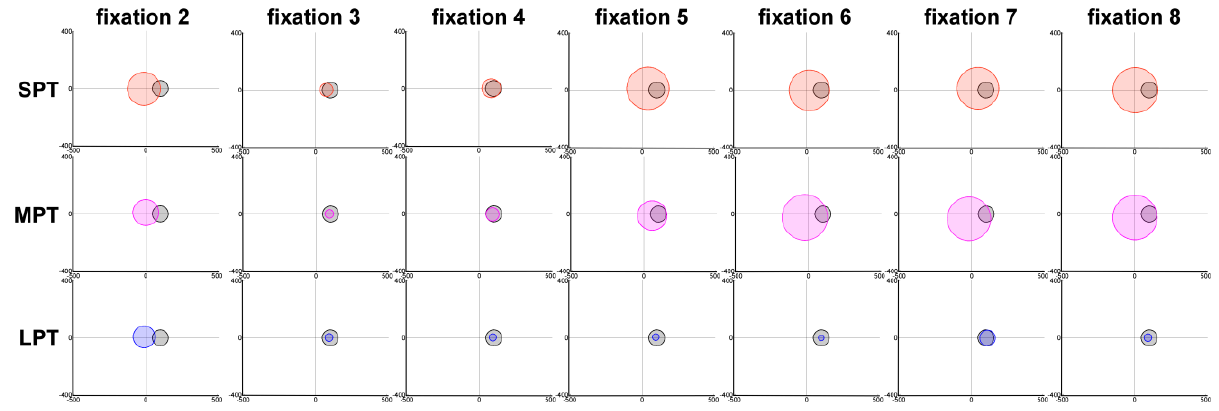
Figure 6: Spatial representation of the evolution of the Gaussian factor, for the three distractor conditions SPT, MPT and LPT as a function of fixation order. The colored circles show the estimated Gaussian factor and are located at the spatial position (𝜇 𝑥 (𝑡), 𝜇 𝑦 (𝑡)) and with a size 𝜎(𝑡) ; these parameters were evaluated by the model.. The black circle shows the distractor location with it size 𝑅 𝑑 corresponding standard errors are plotted. The dark blue line shows the radius 𝑅 𝑑 = 2.2° of the distractor ( A ) and the distance 𝐷 0 of the distractor from the image center ( B ).